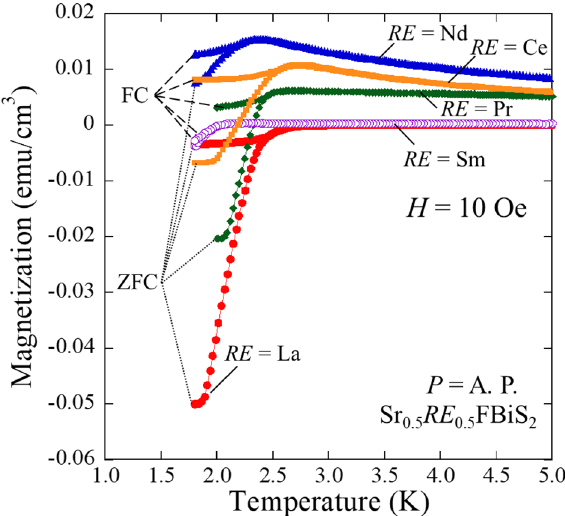
Figure 4. Temperature dependence of magnetization for Sr 0.5 RE 0.5 FBiS 2 ( RE : La, Ce, Pr, Nd, and Sm) at ambient pressure. Dashed and dotted lines indicate a field cooling (FC) and zero-field cooling (ZFC), respectively. A. P. denotes an ambient pressure